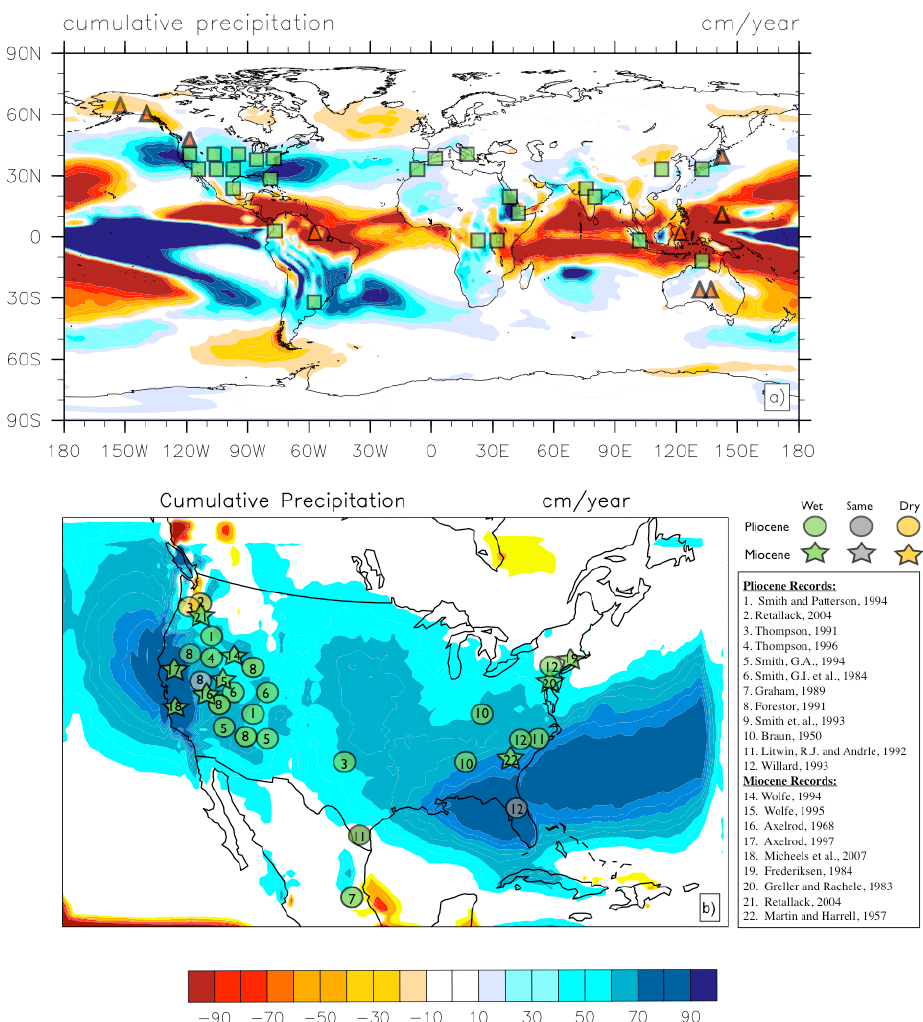
Fig. 1. (a) Summary of the modeled permanent El Ni˜no annual precipitation anomaly (NINO minus MODERN) compared with Pliocene to Miocene proxy data estimates for suggested wet and dry regions, where green squares indicate wetter-than-modern and orange triangles indicate drier-than-modern. (b) RegCM3 modeled precipitation anomaly over US with a proxy compilation for the Pliocene and Miocene. The green dots represents proxy records which indicate wetter-than-modern and the orange dots indicate drier-than-modern during these Neogene warm climate intervals. The sites used in this compilation are found in the reference index and are cited with the appropriate numbering on the climate map. The green circles (wetter-Pliocene), green stars (wetter-Miocene), orange circles (drier-Pliocene), and orange stars